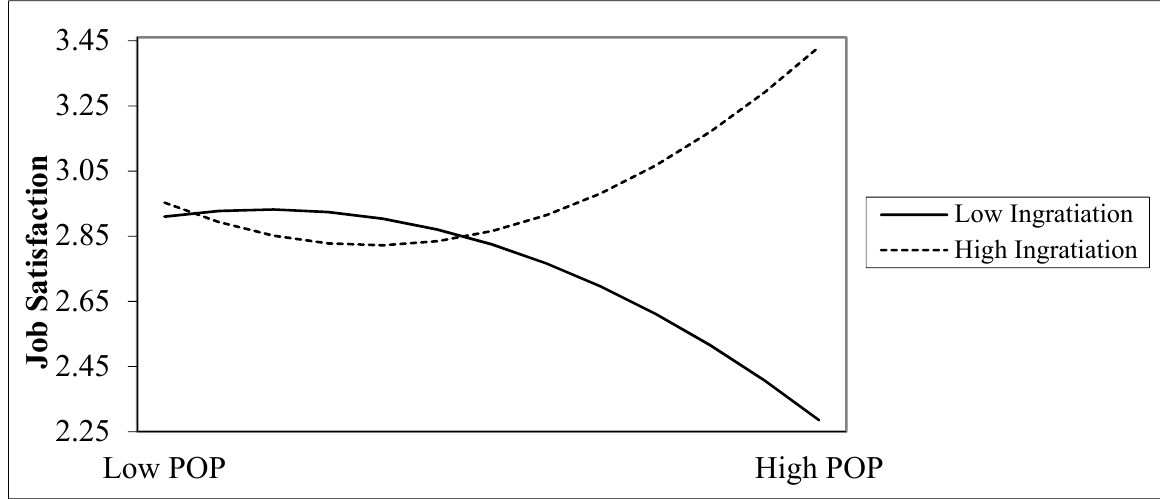
Figure 1. Moderating Effects of Ingratiation on the relationship between Perception of Organizational Politics (POP) and Job Satisfaction.